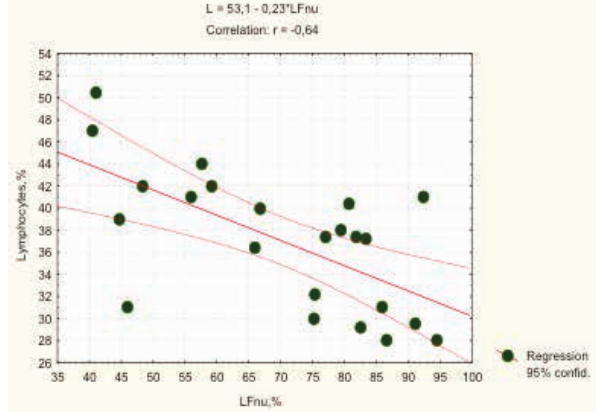
Figure 3: Relationship between normalized LF HRV (X-line) and Lymphocytose